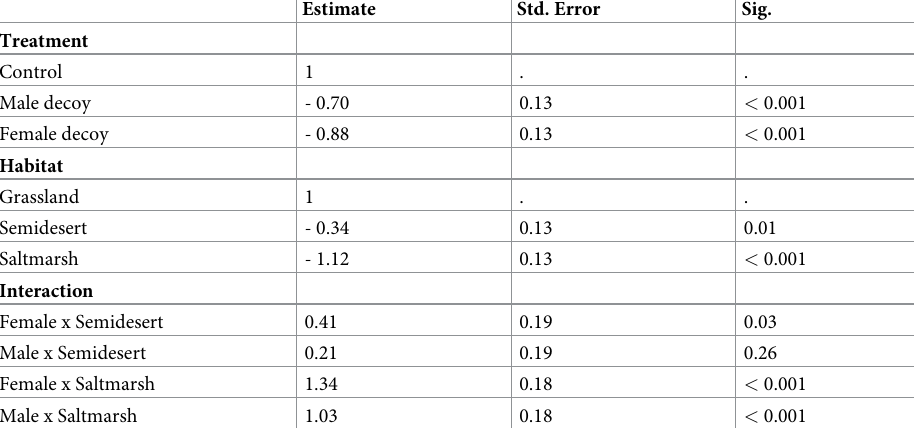
Table 2. General Linear Model using estimated nest survival as response variable: Full model (N = 107 nests). Estimate Std.